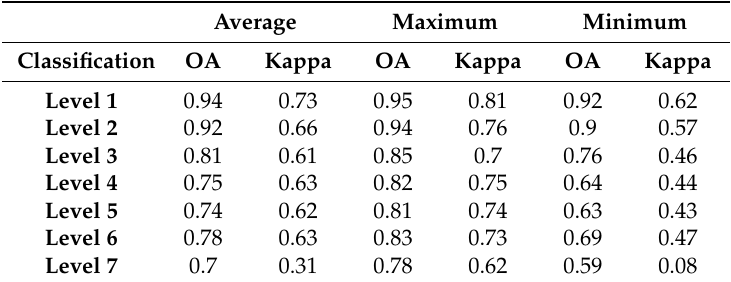
Figure 3. The relationship between the kappa coefficient of each class for Level 7 and the number of points in the class. The horizontal axis is logarithmic. The data are means for the classifications of orbit 29476 with and without atmospheric correction. Table 4. Summary of the classification results by